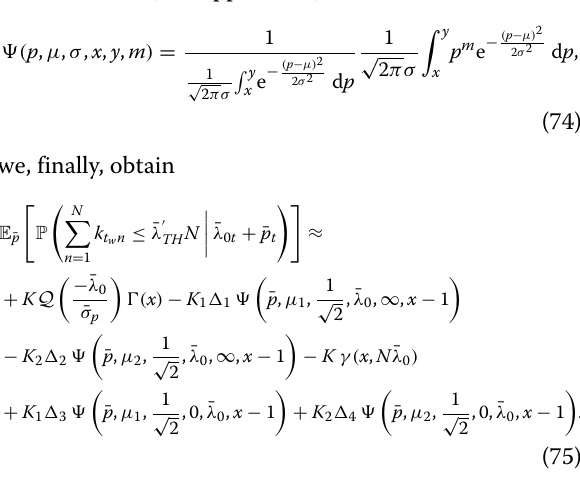
Abbreviations 3GPP: 3rd Generation Partnership Project; CPICH: Common pilot channel; DL: Downlink; FTP: File Transfer Protocol; HSPA: High-Speed Packet Access; PCH: Power Control Headroom; PDF: Probability Density Function; QoS: Quality of service; RF: Radio frequency; SINR: Signal-to-interference plus noise ratio; SM: Small cell; UE: User equipment; UL: Uplink; UMTS: Universal Mobile Telecommunications System; VSAT: Very Small Aperture Terminal; WCDMA: Wide Band Code Division Multiple Access; WiDL: WiFi for Long Distances; WiMAX: Worldwide Interoperability for Microwave